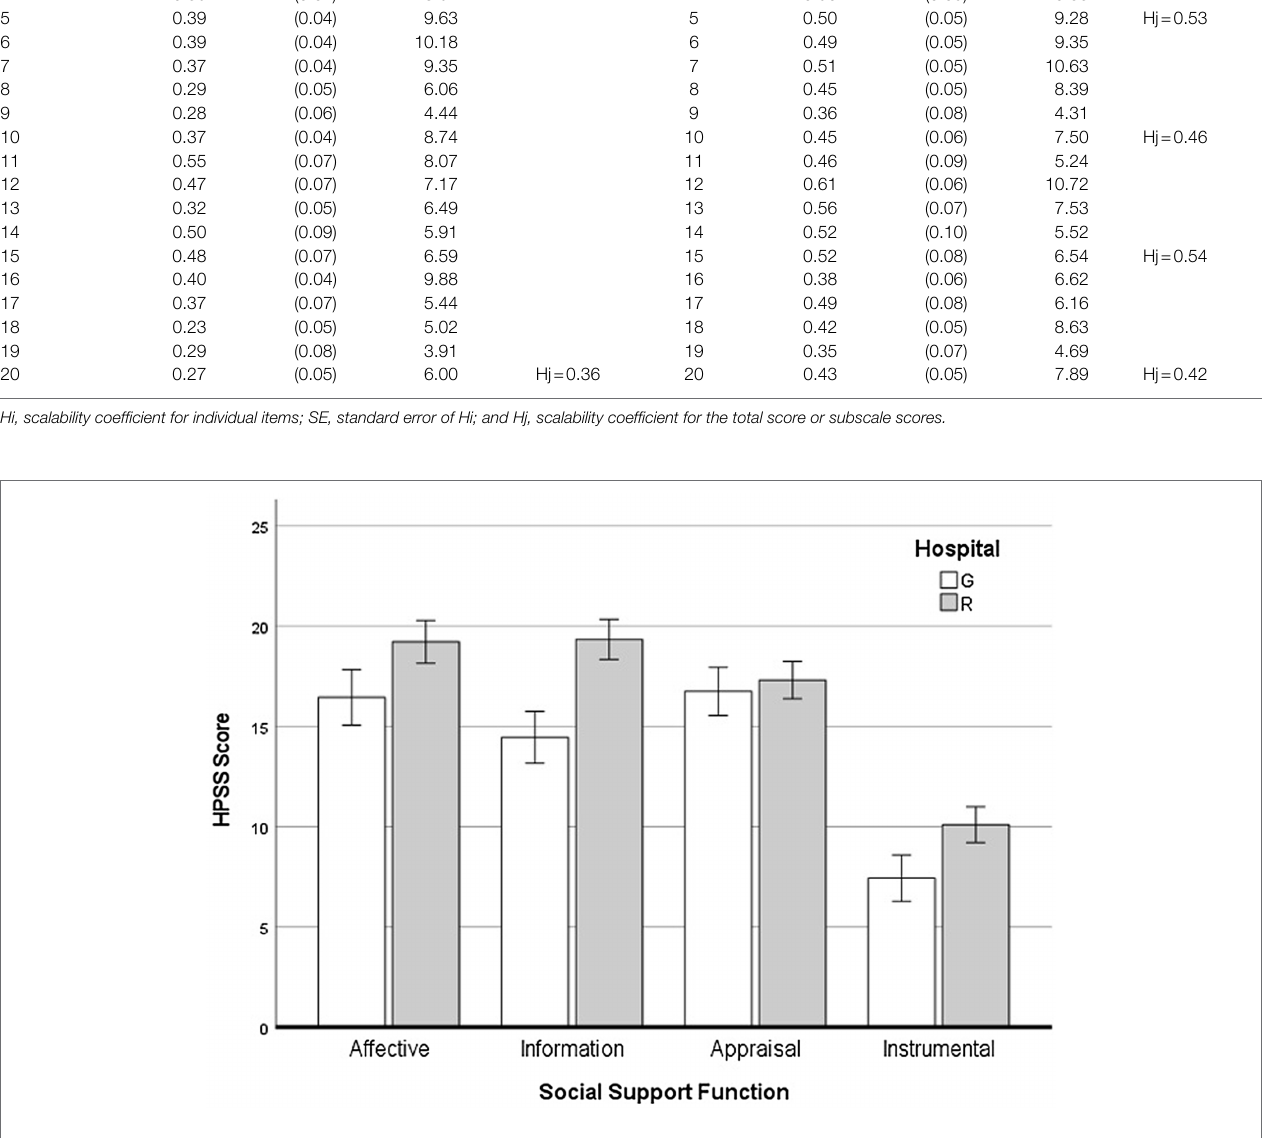
FIGURE 2 | Differences between government-operated (G) and religious (R) hospitals across different social support